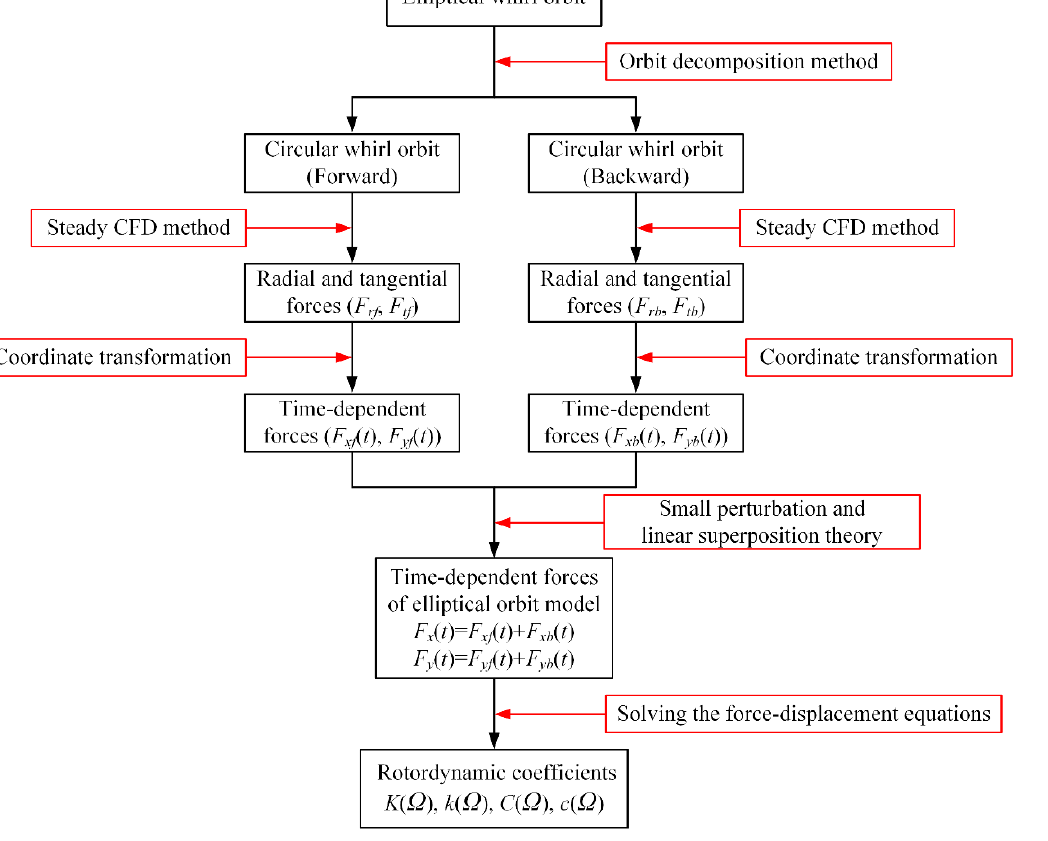
Figure 3. Rotordynamic coefficient identification procedures of orbit decomposition method.